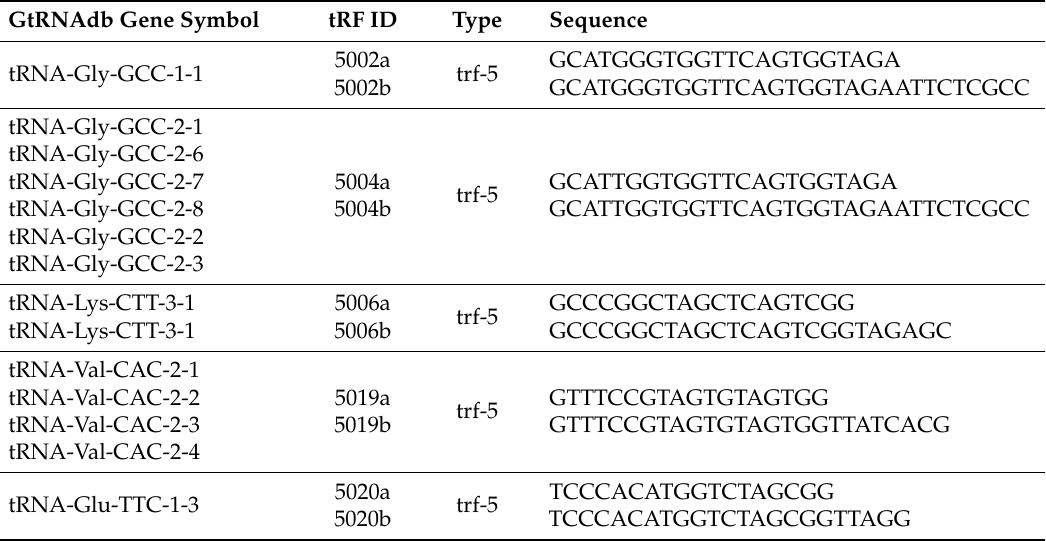
Table 4. The list of 5 ′ -tRFs.